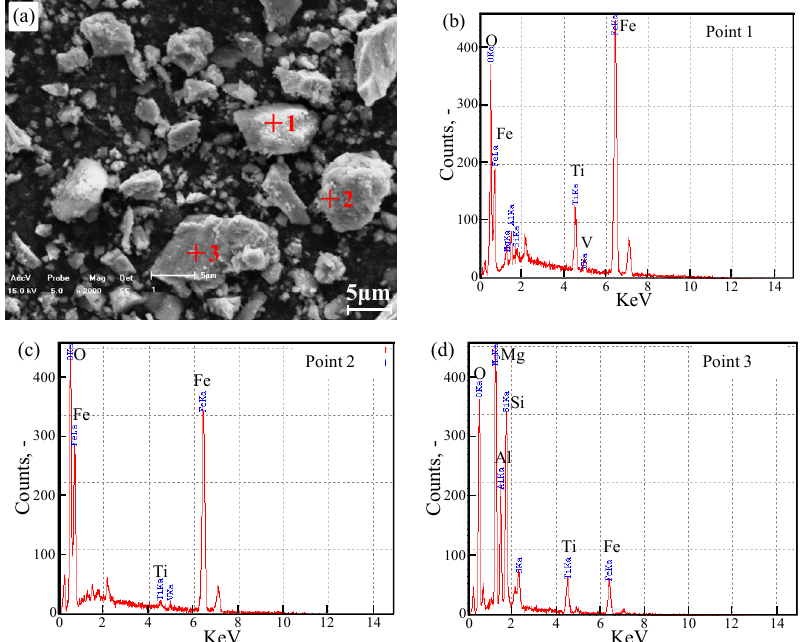
Figure 3. SEM micrograph and EDS of vanadium-bearing titanomagnetite concentrate: ( a ) SEM micrograph; ( b ) EDS of Point 1 in Figure 3a; ( c ) EDS of Point 2 in Figure 3a; ( d ) EDS of Point 3 in Figure 3a.